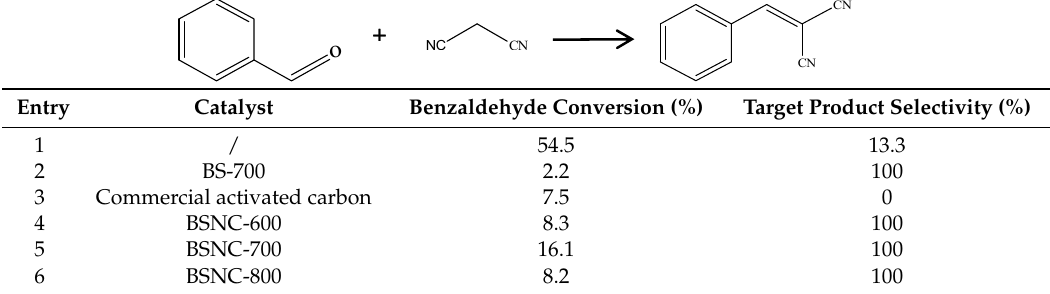
Table 1. Knoevenagel condensation between benzaldehyde and malononitrile in the presence of various catalysts.